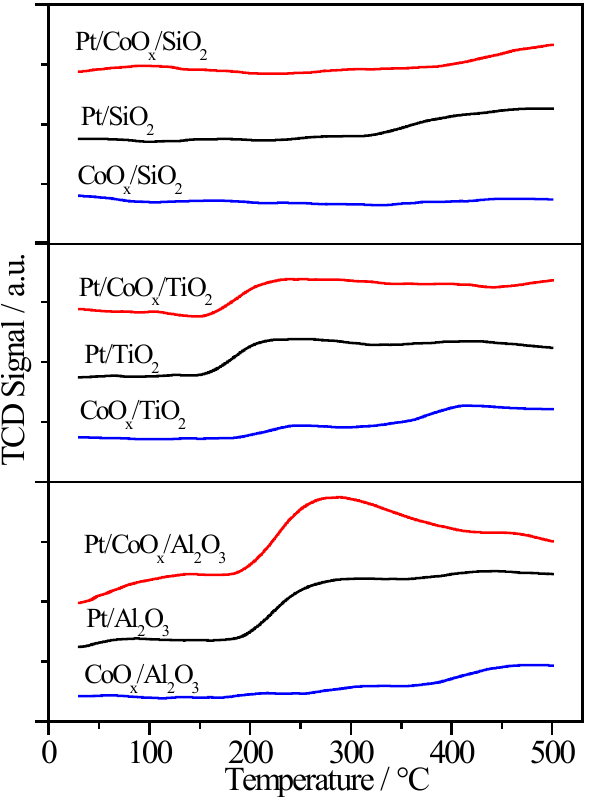
Figure 18. CO-TPD profiles of SiO 2 , TiO 2 , and Al 2 O 3 -based